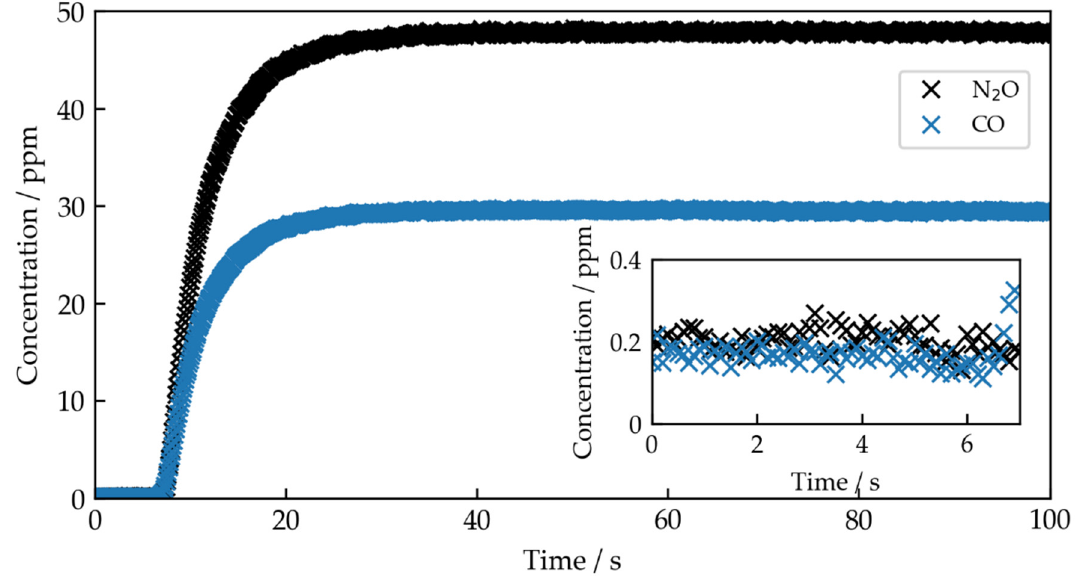
Figure 5. ANN predictions of gas concentrations during gas exchange of the gas cell, which was initially filled with nitrogen and then flushed with a mixture of 30 ppm CO and 50 ppm N 2 O. The inset shows the first 7 s of the measurement, where only nitrogen is present in the cell.